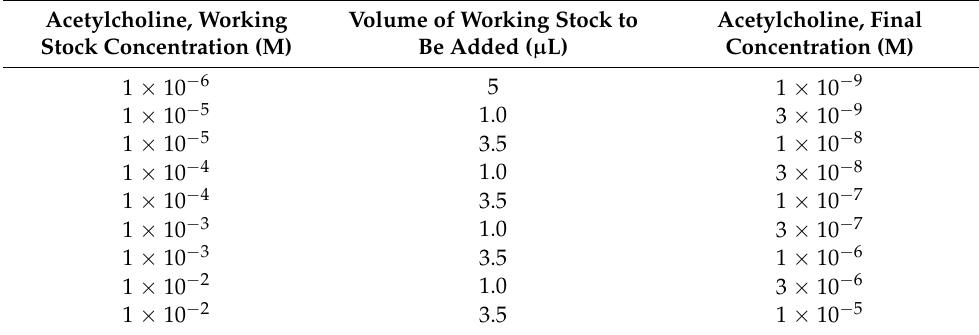
Table 1. Concentrations and volumes of acetylcholine working stocks applied for endothelium- dependent vasorelaxation